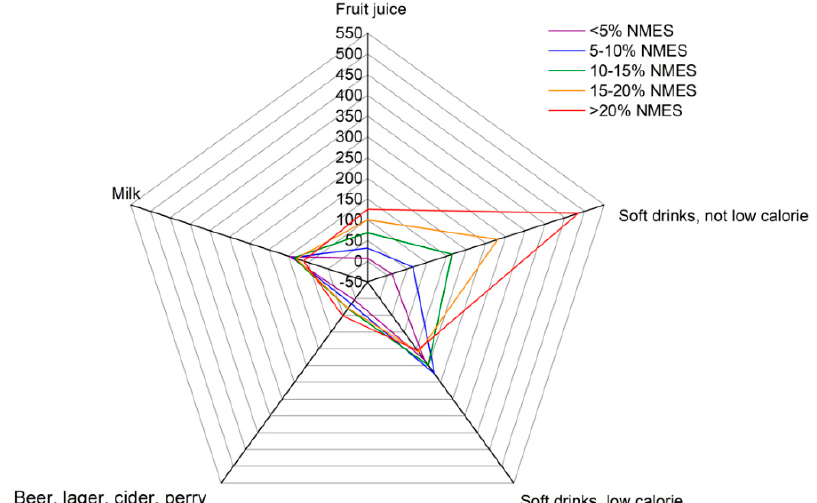
Figure 1. Consumption of alcoholic and non-alcoholic beverages (g / day) by adolescents in the National Diet and Nutrition Survey aged 11 to 18 years, by category of non-extrinsic milk sugar after the application of survey weights.